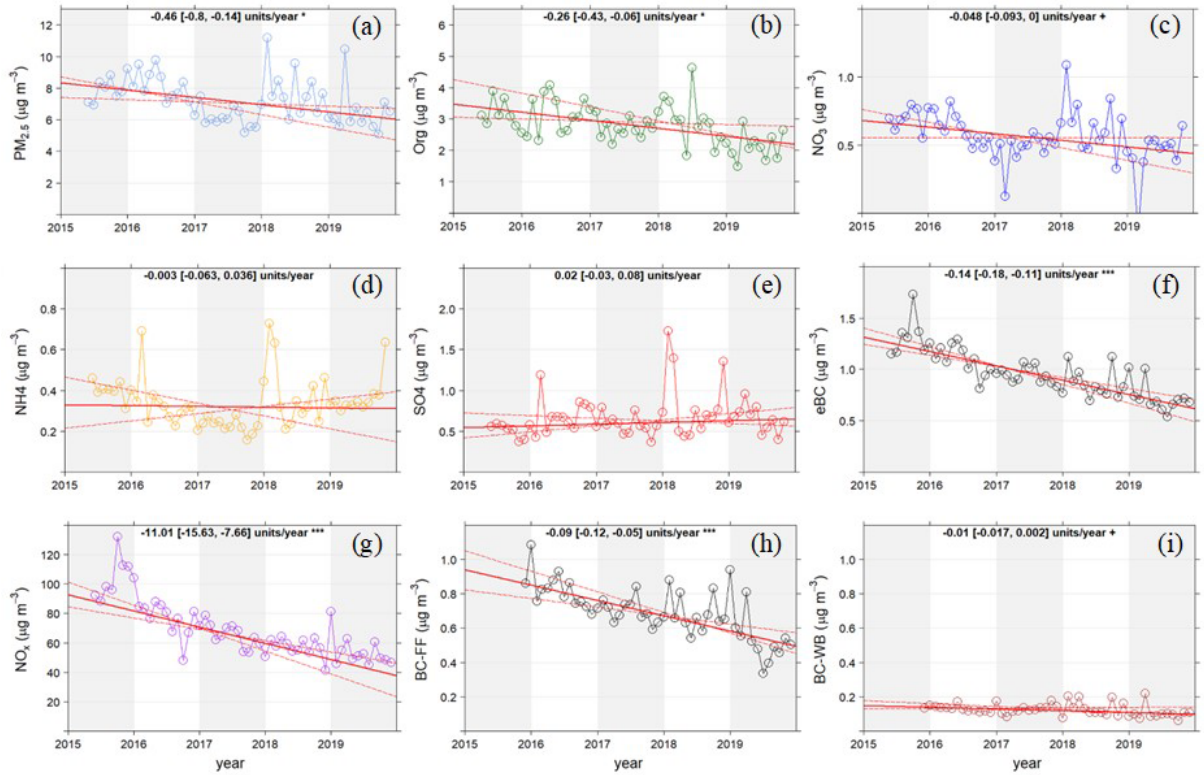
Figure 2. Trend analysis results of selected pollutants ( a : PM 2 . 5 , b : organics, c : NO 3 , d : NH 4 , e : SO 4 , f : eBC, g : NO x , h : BC FF , i : BC WB ). The plots show the deseasonalized monthly mean concentrations of different pollutants. The solid red line shows the trend estimate, and the dashed red lines show the 95% confidence intervals for the trend. The overall trend value is presented at the top centre of each plot as corresponding units per year, and the 95% confidence intervals in the slope are presented in the brackets. The symbols shown next to each trend estimate indicate the statistical significance of the trend estimate ( p < 0 . 001 = ∗∗∗ , p < 0 . 05 = ∗ , and p < 0 . 1 =+